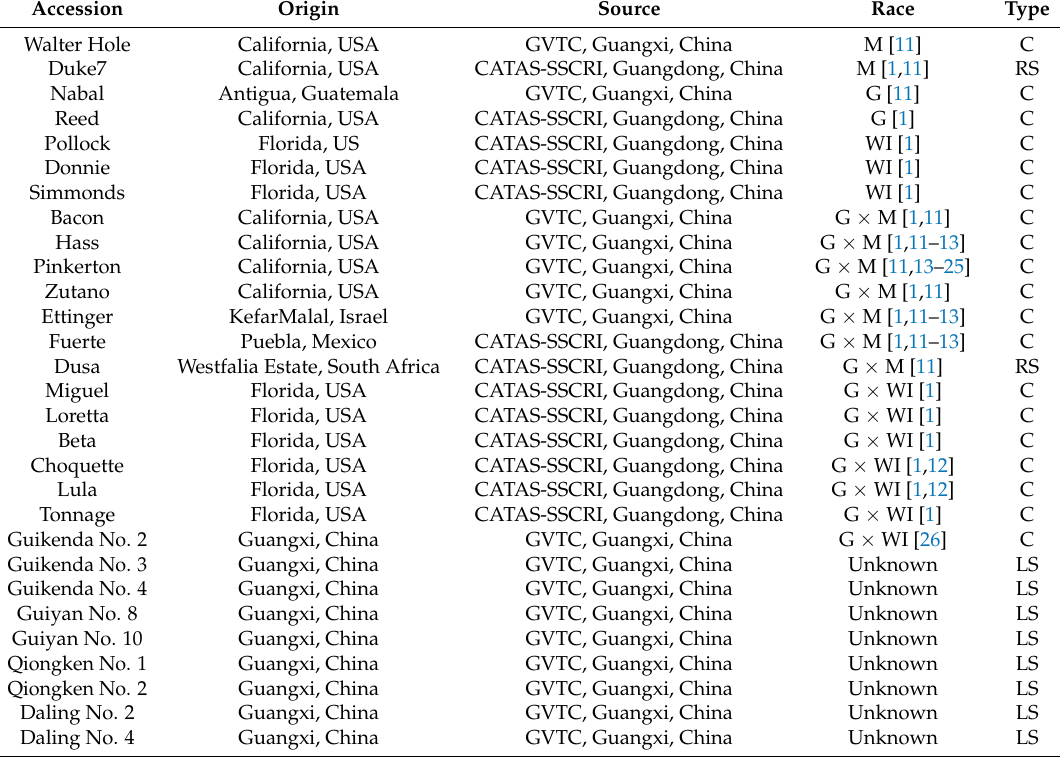
Table 1. Sources of the 29 avocado accessions evaluated in this